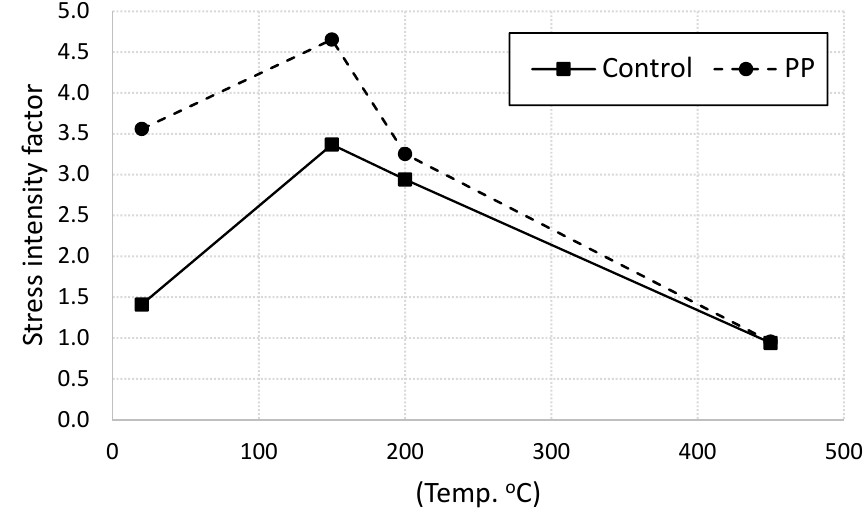
Figure 7. Stress intensity factor for control and fiber-reinforced specimens.